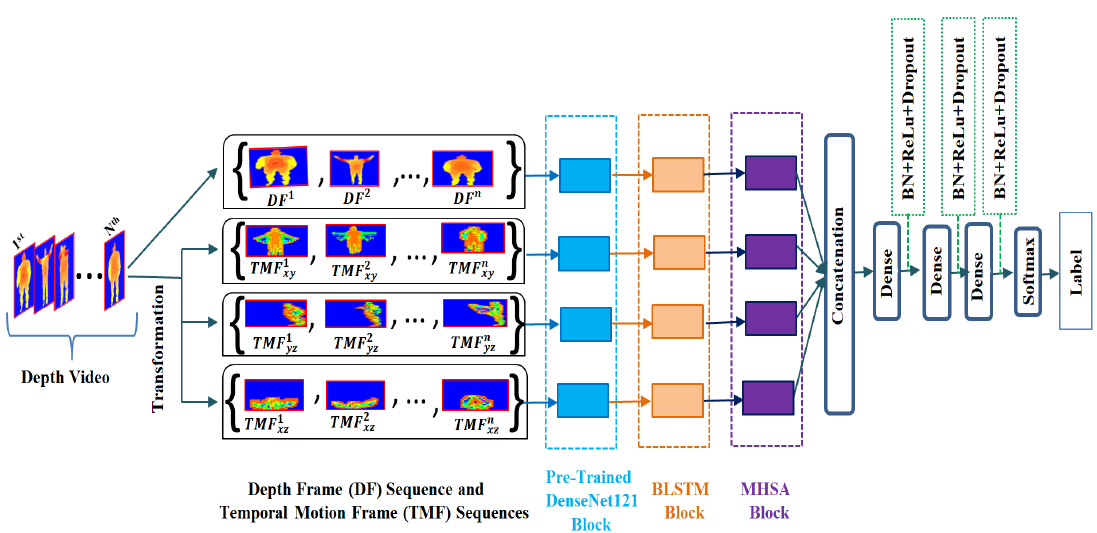
Figure 4. Our depth action classification